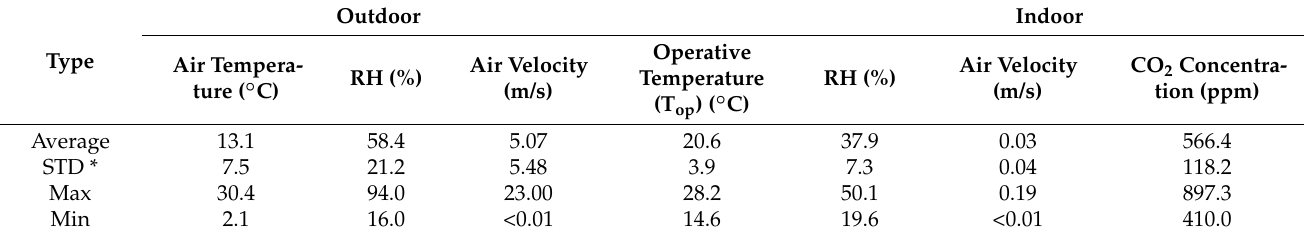
Table 4. Summary of values obtained from the sensor monitoring